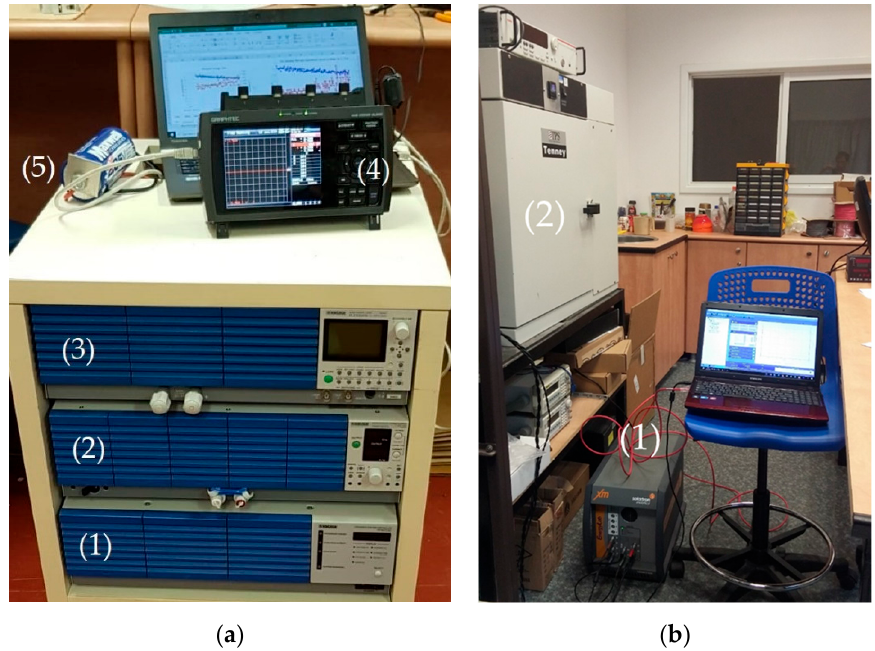
Figure 1. ( a ) Experimental setup for the charge–discharge cycles (1-charge/discharge system controller, 2-regulated DC power supply, 3-electronic load unit, 4-midi-logger, and 5-capacitor). ( b ) Experimental setup for the EIS measurement (1-Potentiostat-galvanostat, and 2-Tenneytemperature test